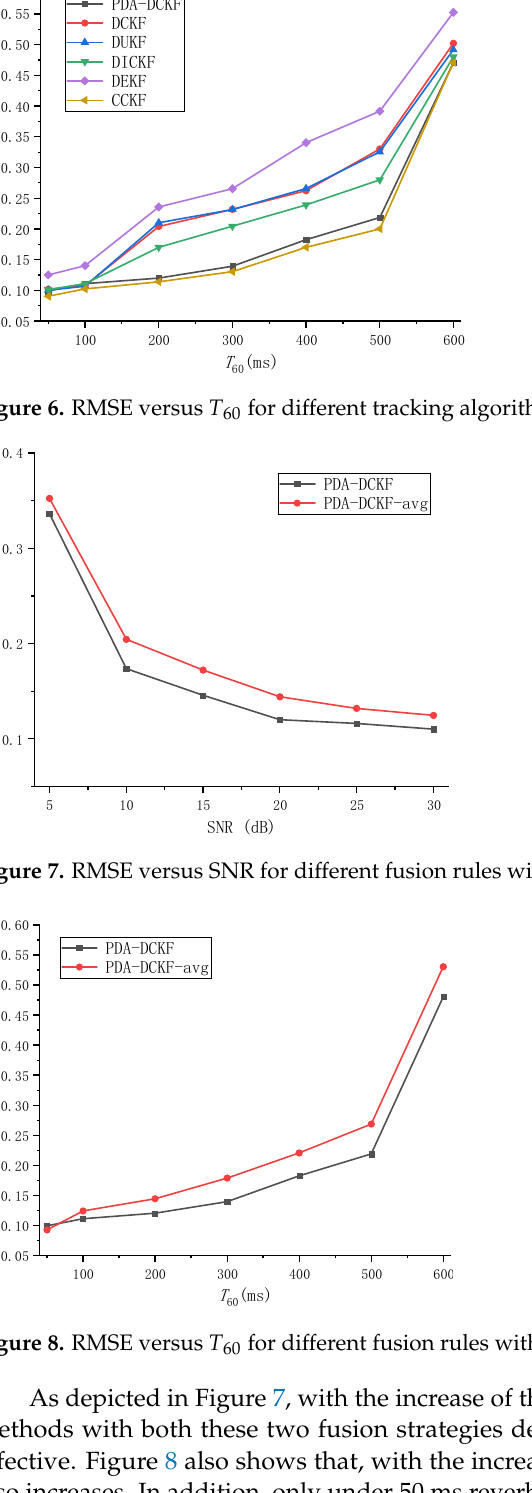
Figure 8. RMSE versus 60